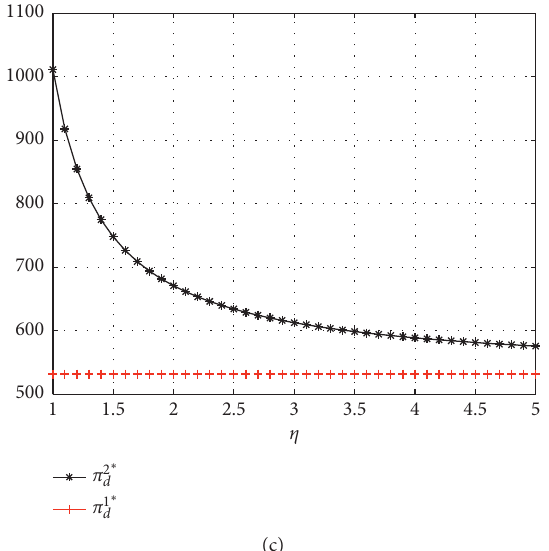
Figure 9: The effect of the value of η on profit under the centralized model and decentralized model.